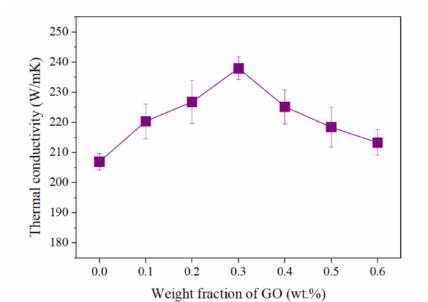
Figure 7. Thermal conductivity of GRAMCs with GO contents of 0 wt.% to 0.6